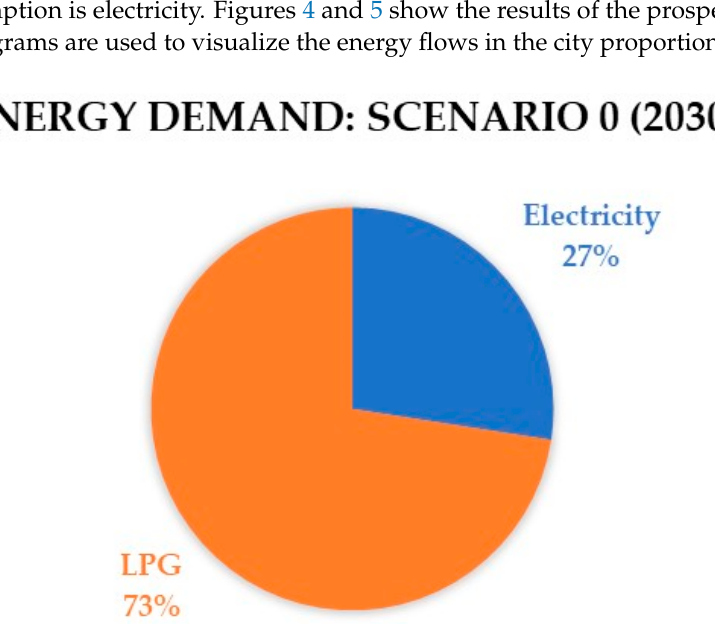
Figure 5. Scenario 0. Sankey diagram for 2030, residential sector. (The figure shows the electricity losses, given by the local distribution company. Losses due to marketing and distribution of LPG have not been included). Scenario 1: An extreme case based on experiences in Chinese cities is con- sidered [6]. In the case of a consolidated market, 95% of the demand covered by this technology could be reached. If, in addition, it is considered that in Cuenca, the solar fraction would not exceed 78% [30], a contribution from other sources, such as electricity or LPG, would be needed. In this scenario, the electricity requirement is 389.4579 kBOE; that is, it decreases by 22.30% with respect to scenario 0. The consumption of LPG is reduced with respect to the base year and represents 64.15% of the total energy consumption. Figures 6 and 7 show the results of the prospective scenario, in- cluding the demand corresponding to heating with ST. Scenario 2. It is proposed that introducing heaters could cover 44% of the demand for domestic hot water by 2030 [31]. Energy consumption in the residential sector is 439.74 kBOE, 14.25% less than that in Scenario 0. As in the previous case, the energy consumption from LPG decreases, accounting for 68.2% of the total energy required by the residential sector. Figures 8 and 9 show the results of the prospective scenario, including the energy from ST.